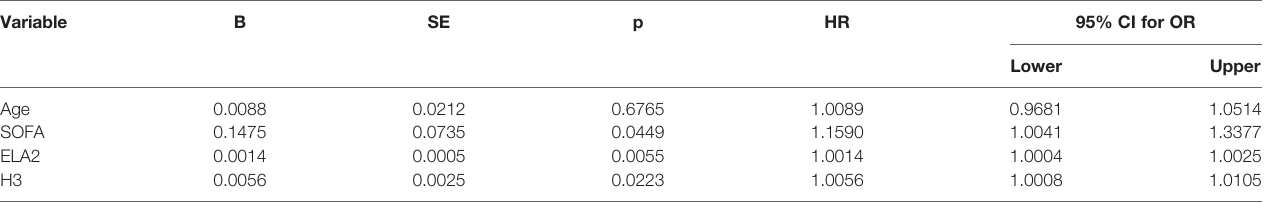
TABLE 6 | Cox regression analysis for possible risk factors for prognosis.